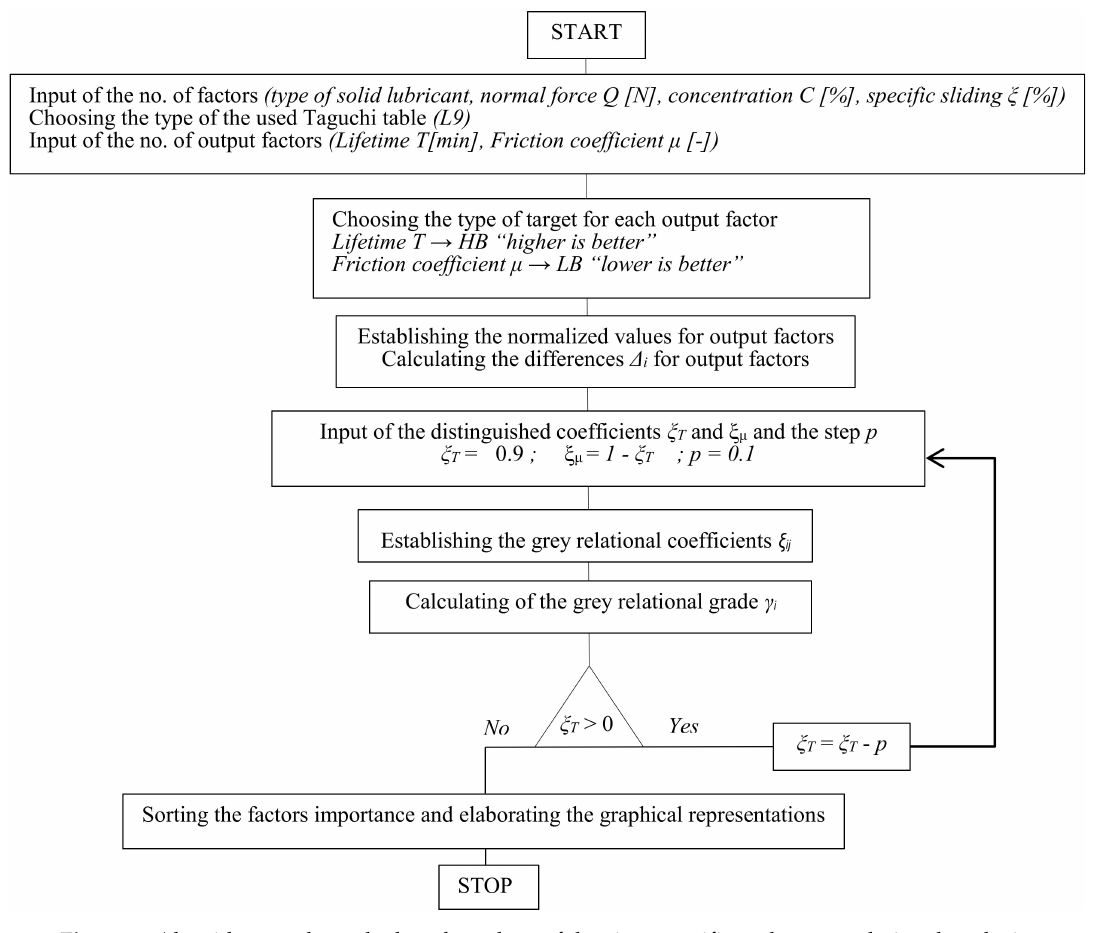
Figure 1. Algorithm used to calculate the values of the sizes specific to the grey relational